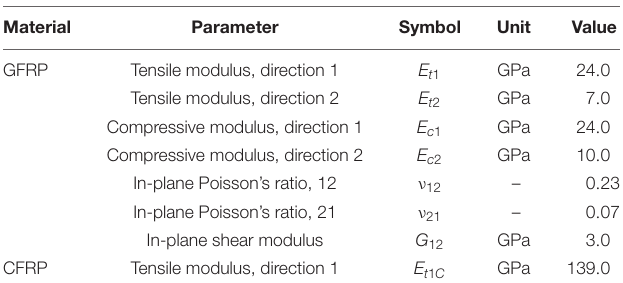
TABLE 1 | Characteristic stiffness values of the FRP